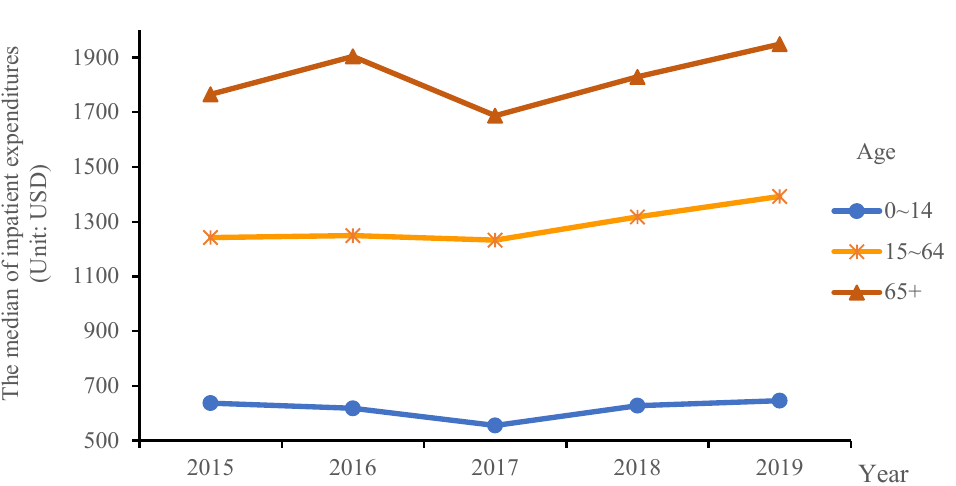
Figure 3. Trends in inpatient expenditure for different ages for respiratory diseases for 2015–2019.